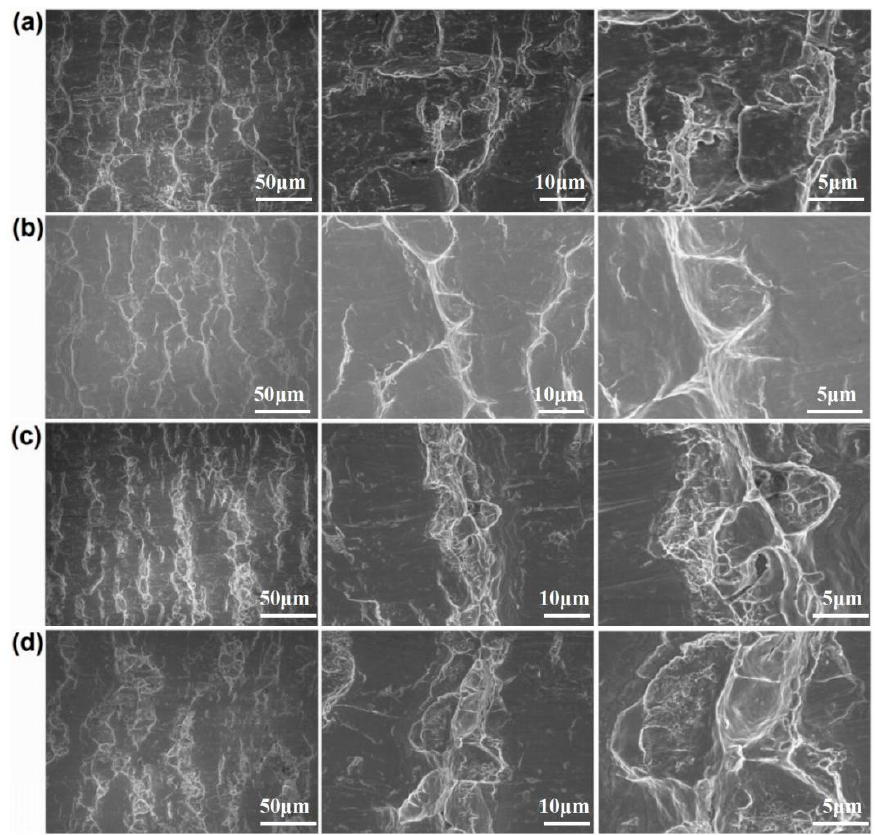
Figure 8. Peeling surface morphology on the aluminium side. ( a ) Specimen B2; ( b ) specimen B3; ( c ) specimen C2; ( d ) specimen C3.